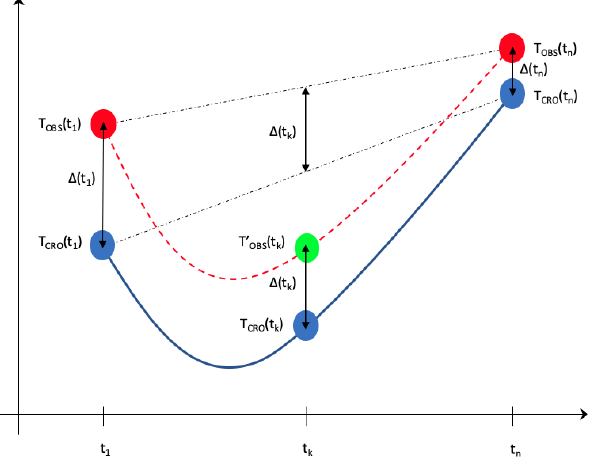
Figure A1. Schematic diagram of the method of filling in the miss- ing values observed from a numerical simulation with the CROCUS model.